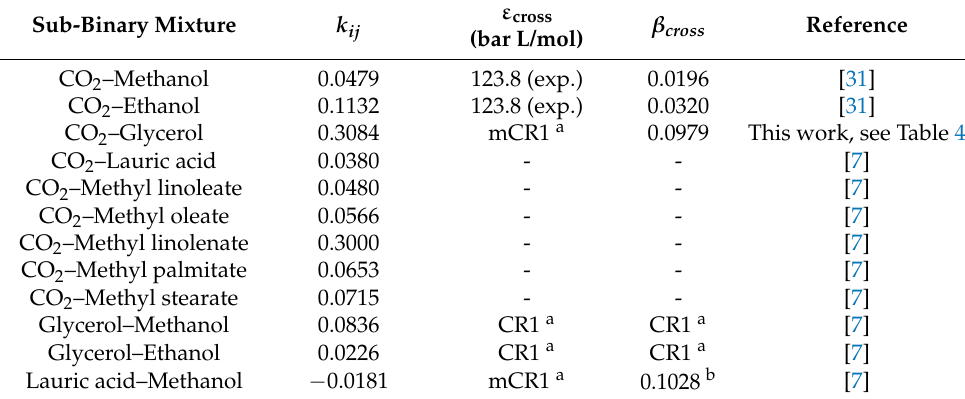
Table 6. Binary parameters used in calculations for ternary or multicomponent systems.